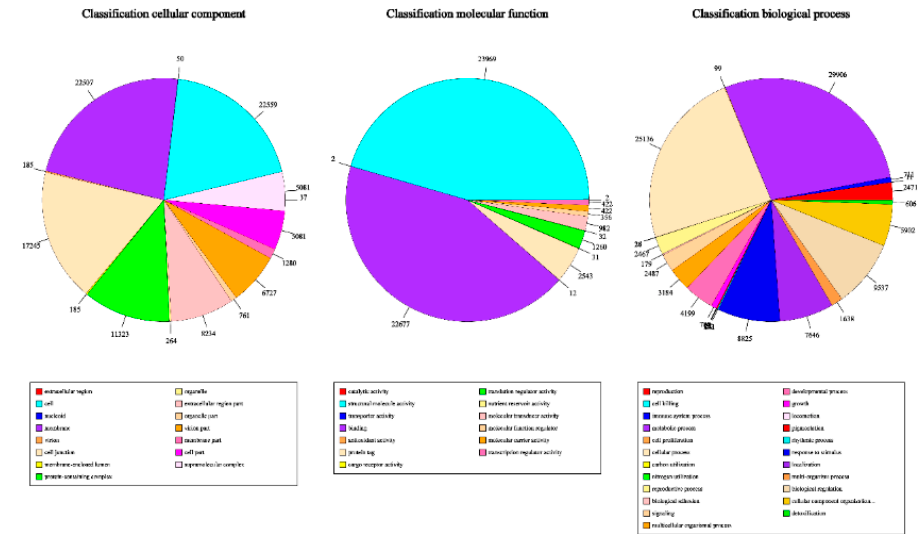
Figure 8. GO function classification. COG analysis classified these unigenes into 25 categories. Amino acid transport and metabolism was the most frequent functional category, followed by cell motility (Figure 9). KEGG annotation annotated 20,548 unigenes to 150 pathways (Table S5), which can be divided into 22 categories (Figure